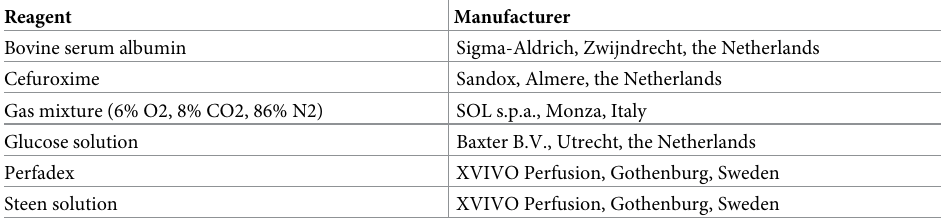
Table 1. List of reagents for ex vivo lung perfusion.